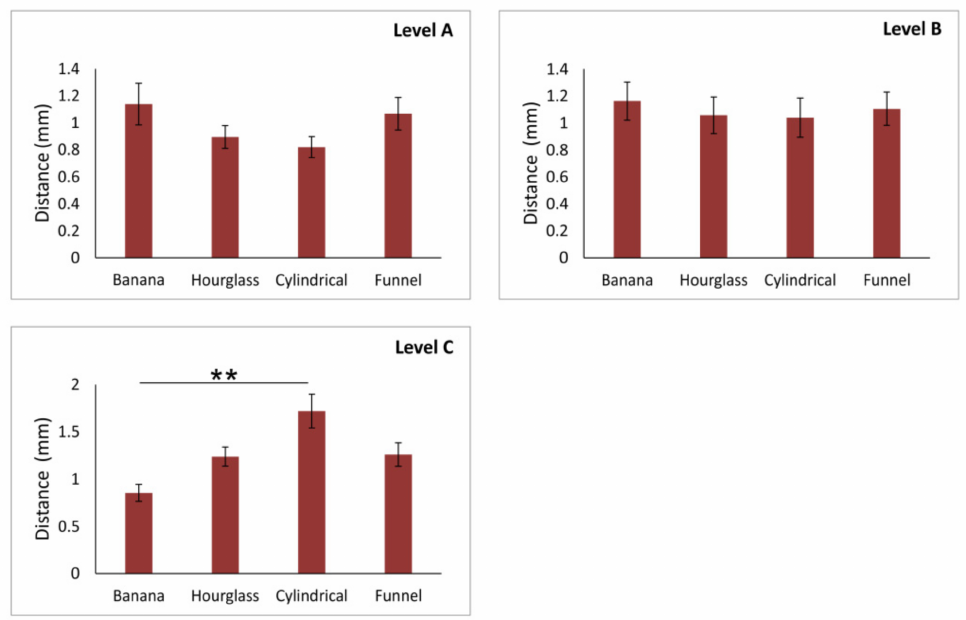
Figure 6. The distance of accessory canal from central incisor at different levels of anterior maxilla according to NPC shape. Values are expressed as the mean ± SEM. ** denotes a significant difference of p <